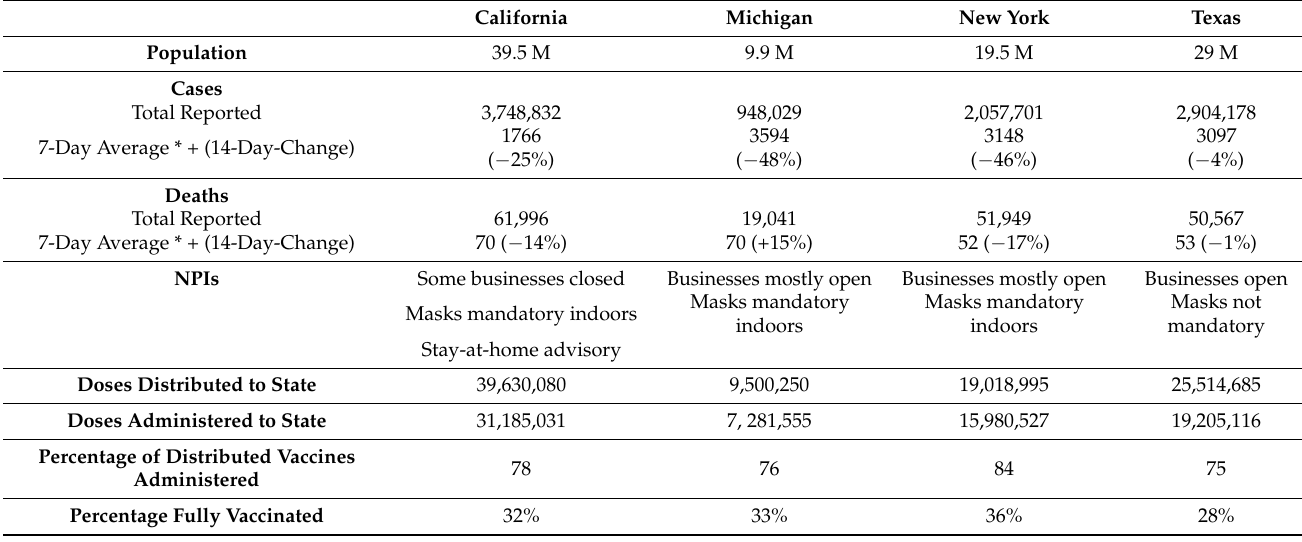
Table 1. “NPIs and Case Counts in California, Michigan, New York, and Texas”